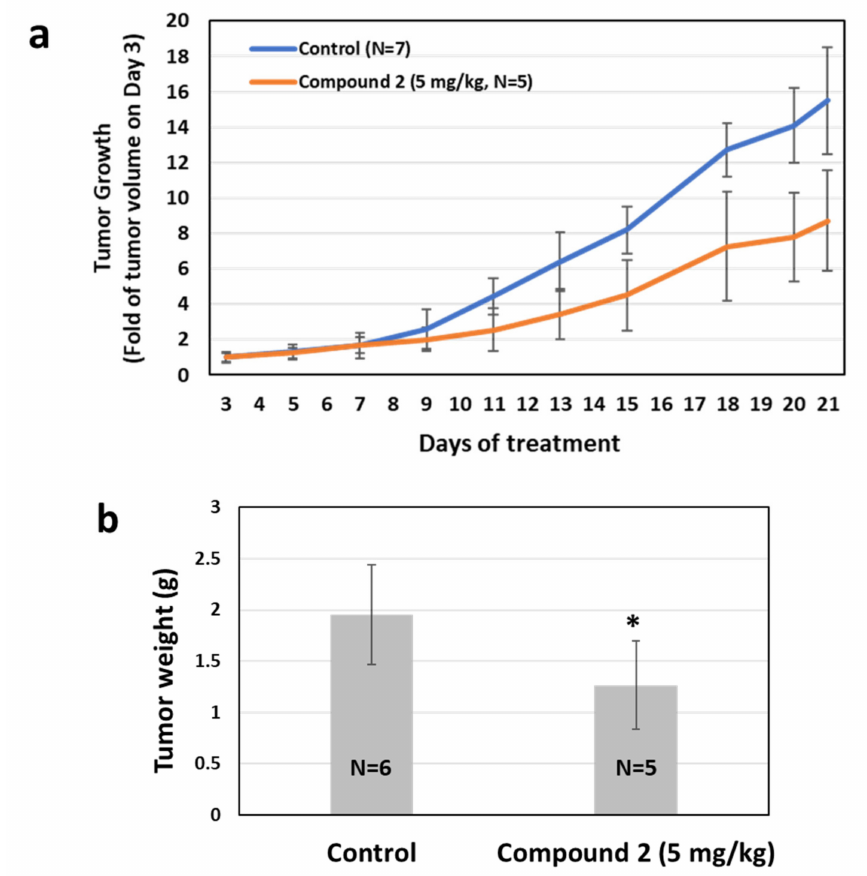
Figure 5. Compound 2 inhibited the tumor growth of human melanoma in vivo . Metastatic melanoma A375 cells were injected into male nude mice subcutaneously on the flank. Compound 2 treatment (5 mg/kg, IP, daily) inhibited tumor growth ( a ) and reduced tumor weight ( b ). ( a ) Tumor volume was measured by digital calipers and determined using the formula (mm 3 ) = (L × W 2 )/2. Tumor growth was presented as a fold increase in size from day 3 (mean ± SD). ( b ) Comparison of measured tumor burden (via weight) after 21 days of therapy. The p values were determined using a two-tailed Student’s t -test. * p < 0.05 compared to control